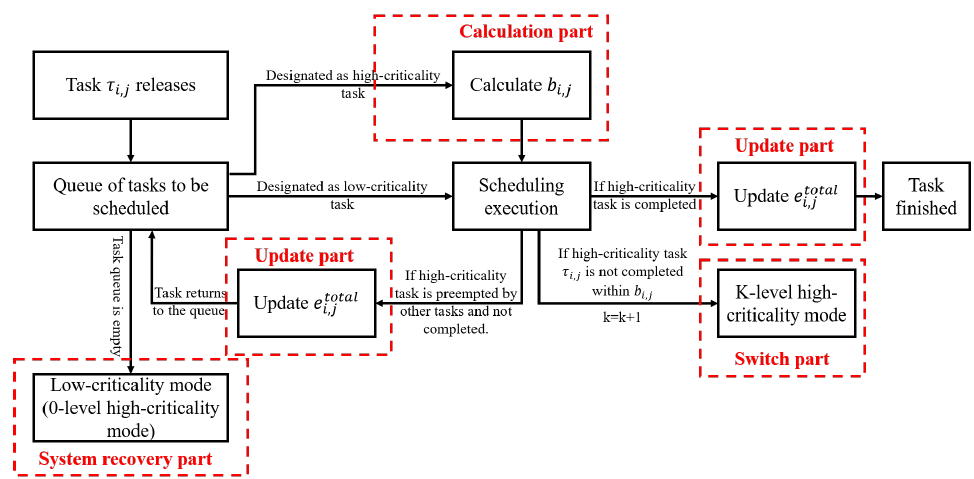
Figure 4. The maximum execution budget allocation